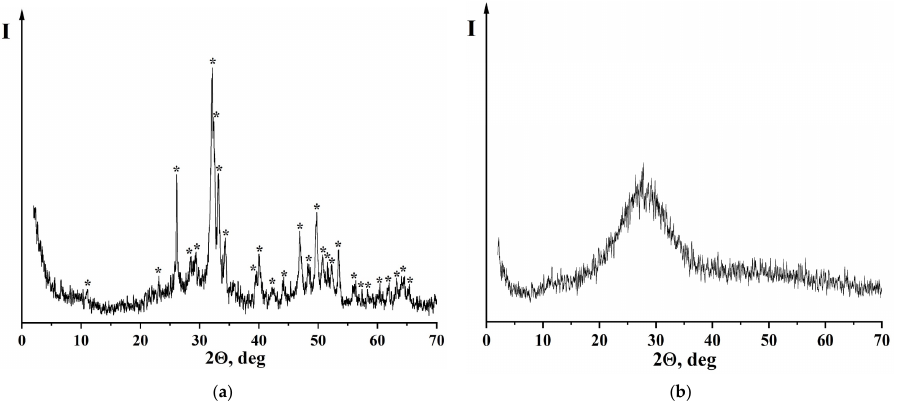
Figure 1. XRD pattern of the pre-ceramic samples obtained from pastes after their air drying in molds and subsequent heat treatment at 60 °C for 24 h: *—Ca 10 (PO 4 ) 6 (OH) 2 (PDF card 9-432) ( a ). XRD pattern of the aqueous solution of sodium silicate after 60 °C with exposure of 24 h ( b ). The SEM data of pre-ceramic samples show that the particles of HA powder (Figure 2a) after mixing with SS aq and air drying are bounded to each other by a curable mass— amorphous hydrated sodium silicate (Figure 2b). The particle size distribution of a commercial HA is illustrated in Figure 2c. A high level of the specific surface area of HA powder leads to a small count of powder for obtaining homogeneous plastic molding